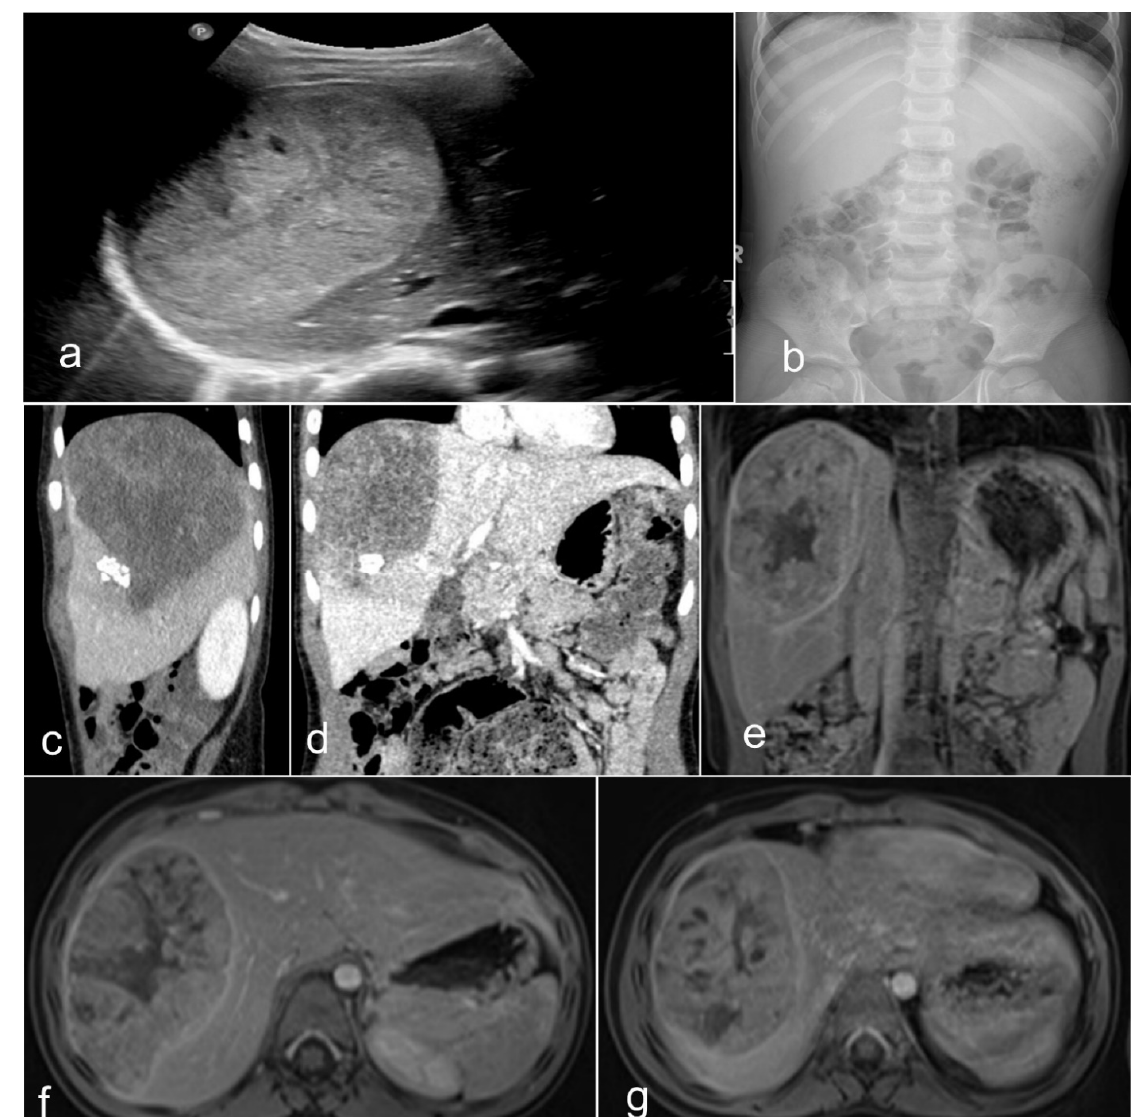
Figure 2. Imaging of a teratoid hepatoblastoma showing a heterogeneous mass encased in the liver ( a ), which is very close to the diaphragm ( b ). The magnetic resonance imaging ( c – g ) shows a large neoplasm in the right upper quadrant of the abdomen deriving from the right liver lobe. The neoplasm has two main portions and seems to contain different portions of tissue. The coronal view showed that the tumor is exophytic, protruding superiorly (T2 sequence). Remarkably, the transversal view typically reveals that the ventral tumor portion has a cystic nonenhancing appearance, whereas the dorsal part emerges more solid (T2 sequence). The T1 sequences—after contrast (post-gadolinium) application—( e – g ) display an inhomogeneous contrast enhancement. The ventral portion of the hepatic neoplasm is intriguingly avidly enhancing, while the dorsal solid portion enhances less